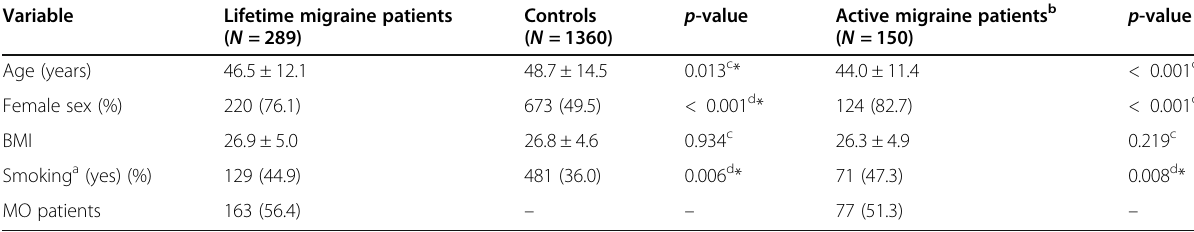
Table 1 Demographic